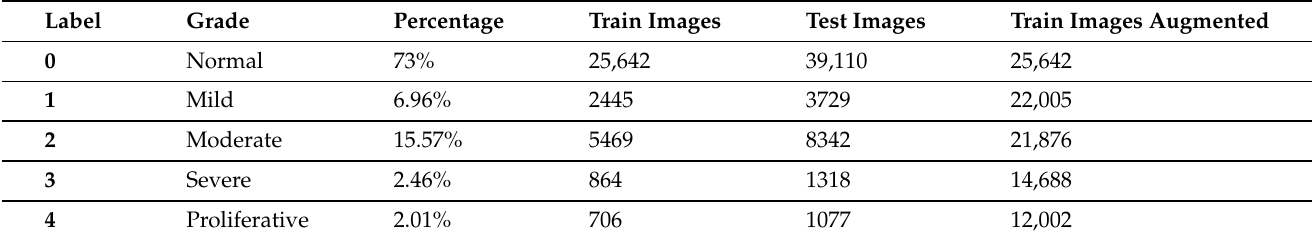
Table 1. Distribution of classes in Kaggle